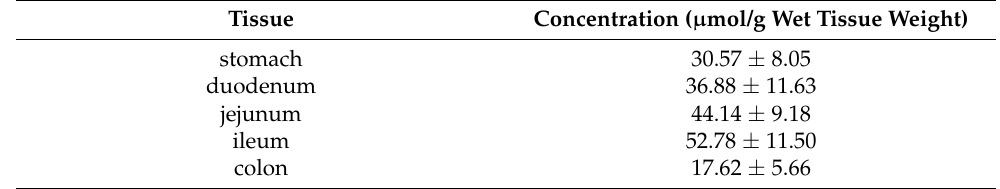
Table 1. Concentration of S -MRI-1867 in different segments of the gastrointestinal tract.